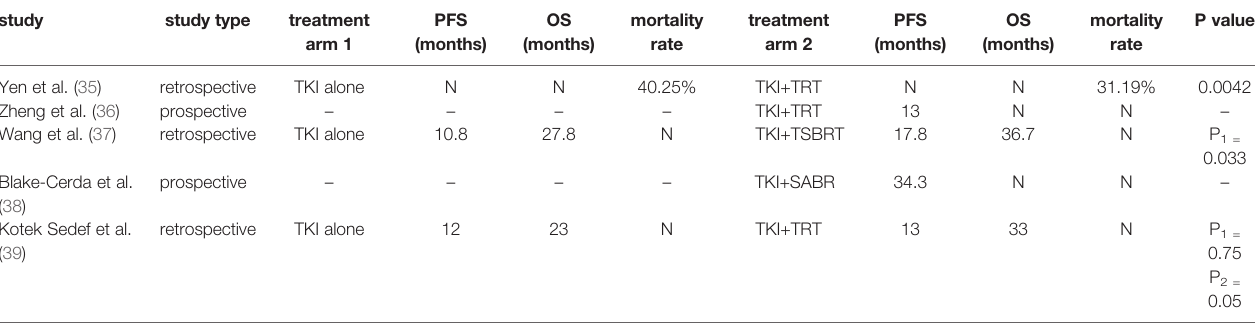
TABLE 1 | Clinical outcomes of TKI alone or combined with TRT for advanced oncogene-driven